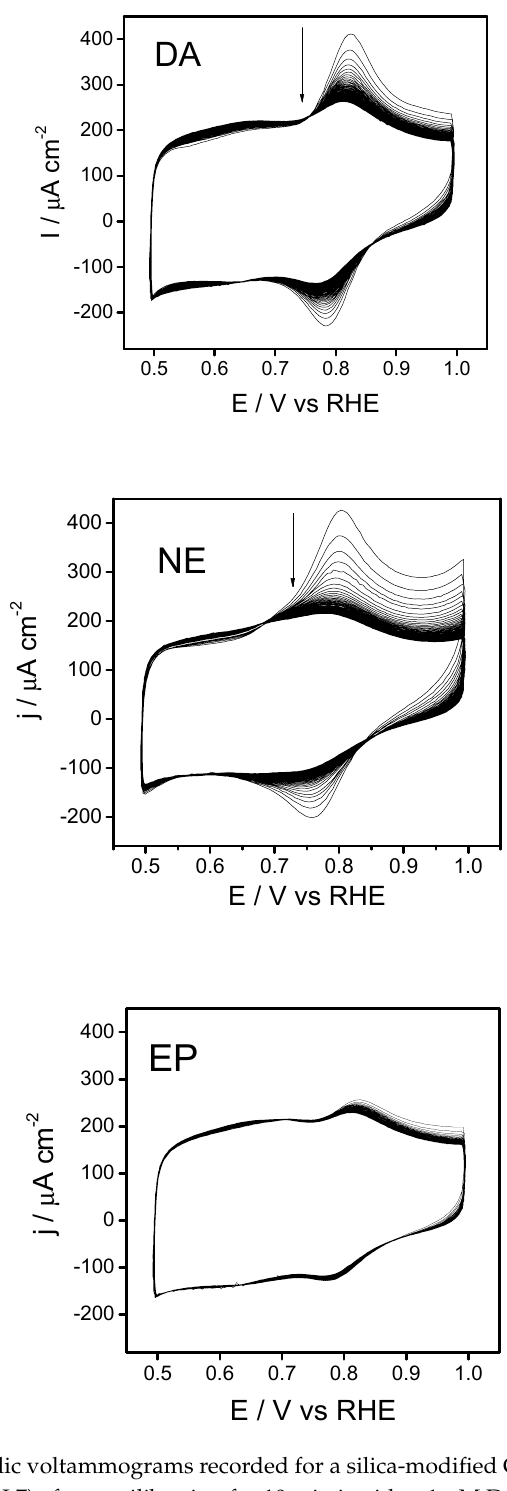
Figure 5. Successive cyclic voltammograms recorded for a silica-modified GC electrode recorded in a blank PBS solution (pH 7) after equilibration for 10 min in either 1mM DA, 1 mM NE, or 1mM EP solution. T = 25 °C. Scan rate 100 mV s − 1 in all cases.